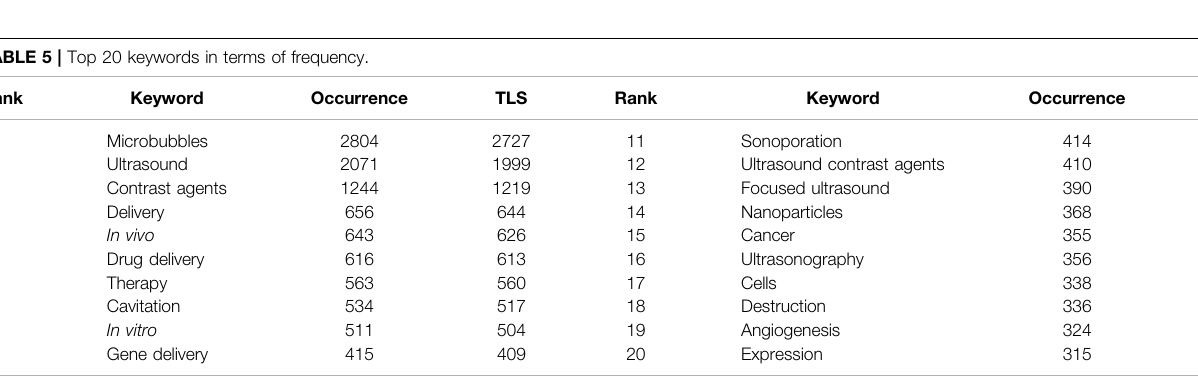
TABLE 5 | Top 20 keywords in terms of